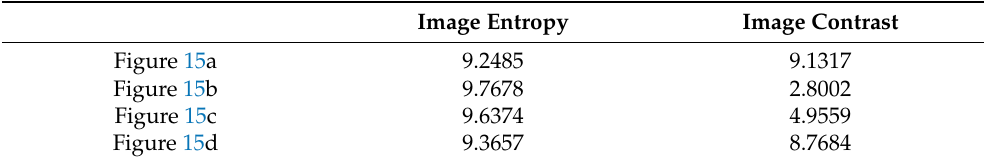
Table 6. Image entropy and image contrast of the imaging